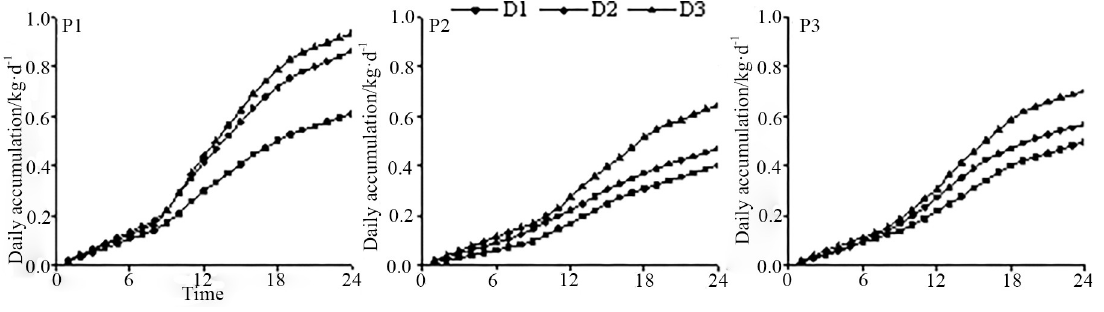
Fig 5. Diurnal daily accumulation changes of Salix psammophila’ s